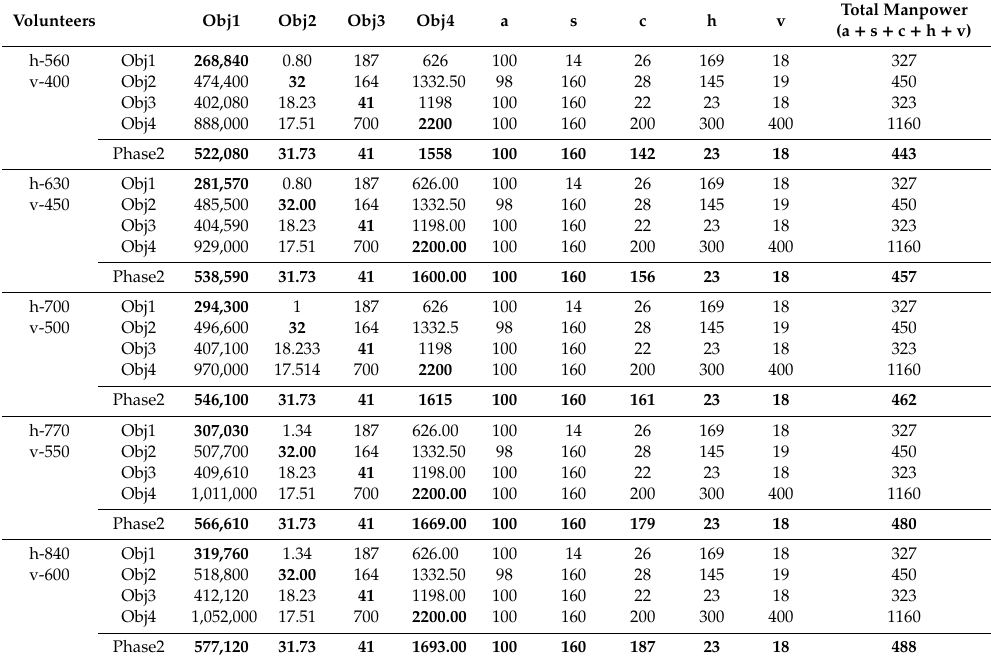
Table A4. Sensitivity of optimal scheduling with respect to increasing cost of using volunteers (i = 7).